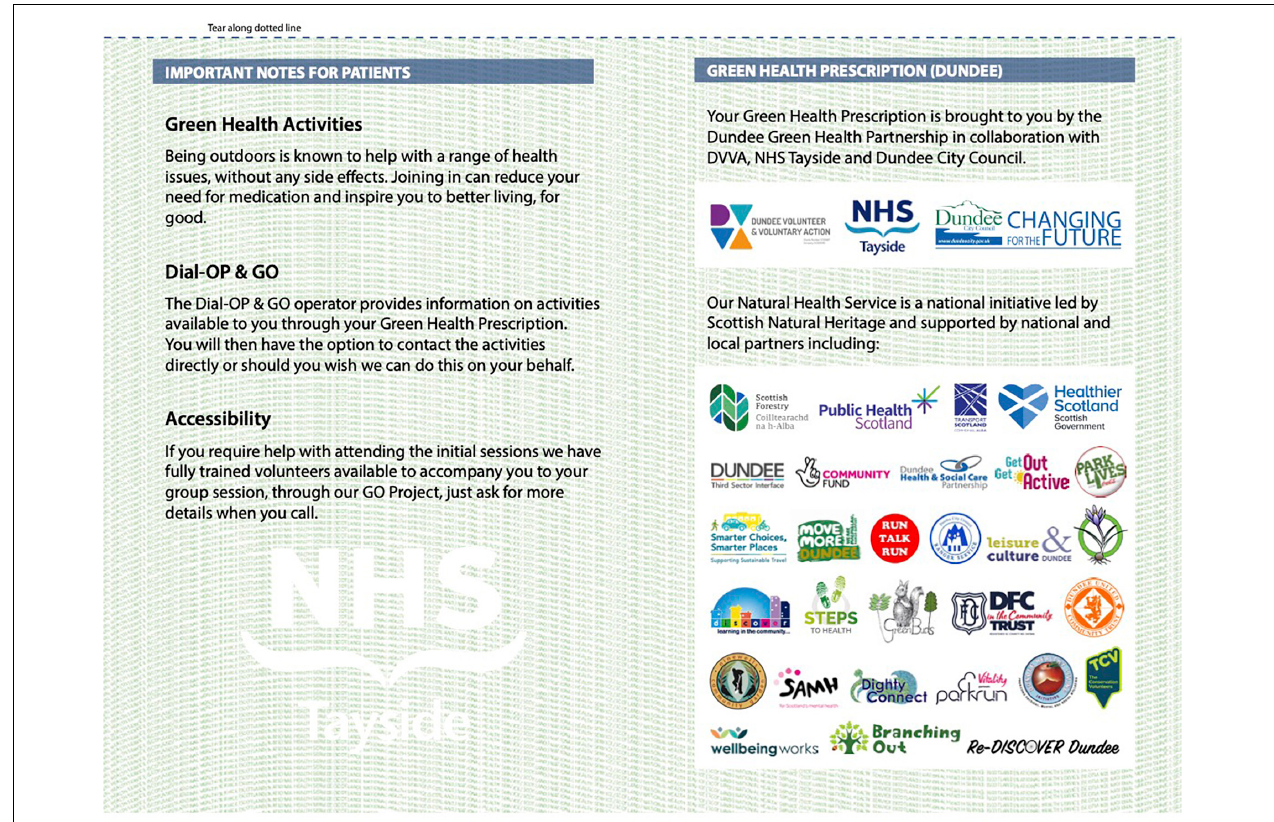
FIGURE 2 | Green Health Prescription back side. © Copyright of Green Health